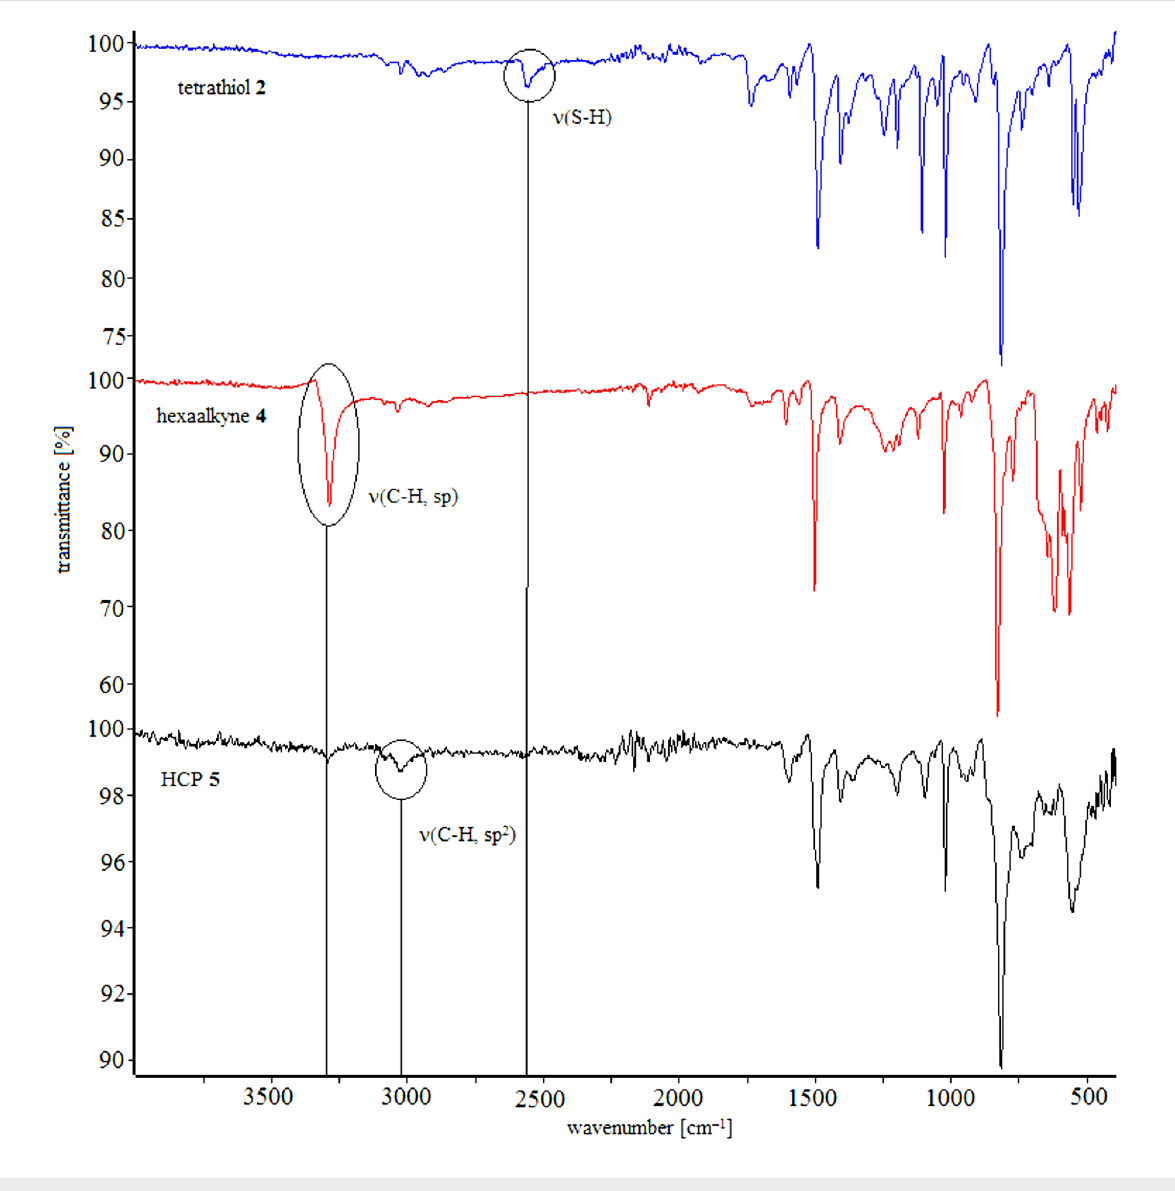
Figure 2: IR-spectra of tetrathiol 2 (blue), hexaalkyne 4 (red) and HCP 3 (black).